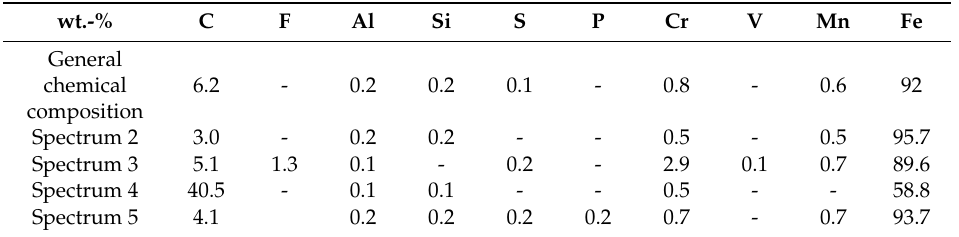
Figure 6. SEM-energy dispersive spectroscopy (EDS) local chemical composition of metallic material obtained after CC02 dilatometer test. Table 4. SEM-EDS chemical composition of obtained metallic material after CC02 dilatometer test (% by weight).